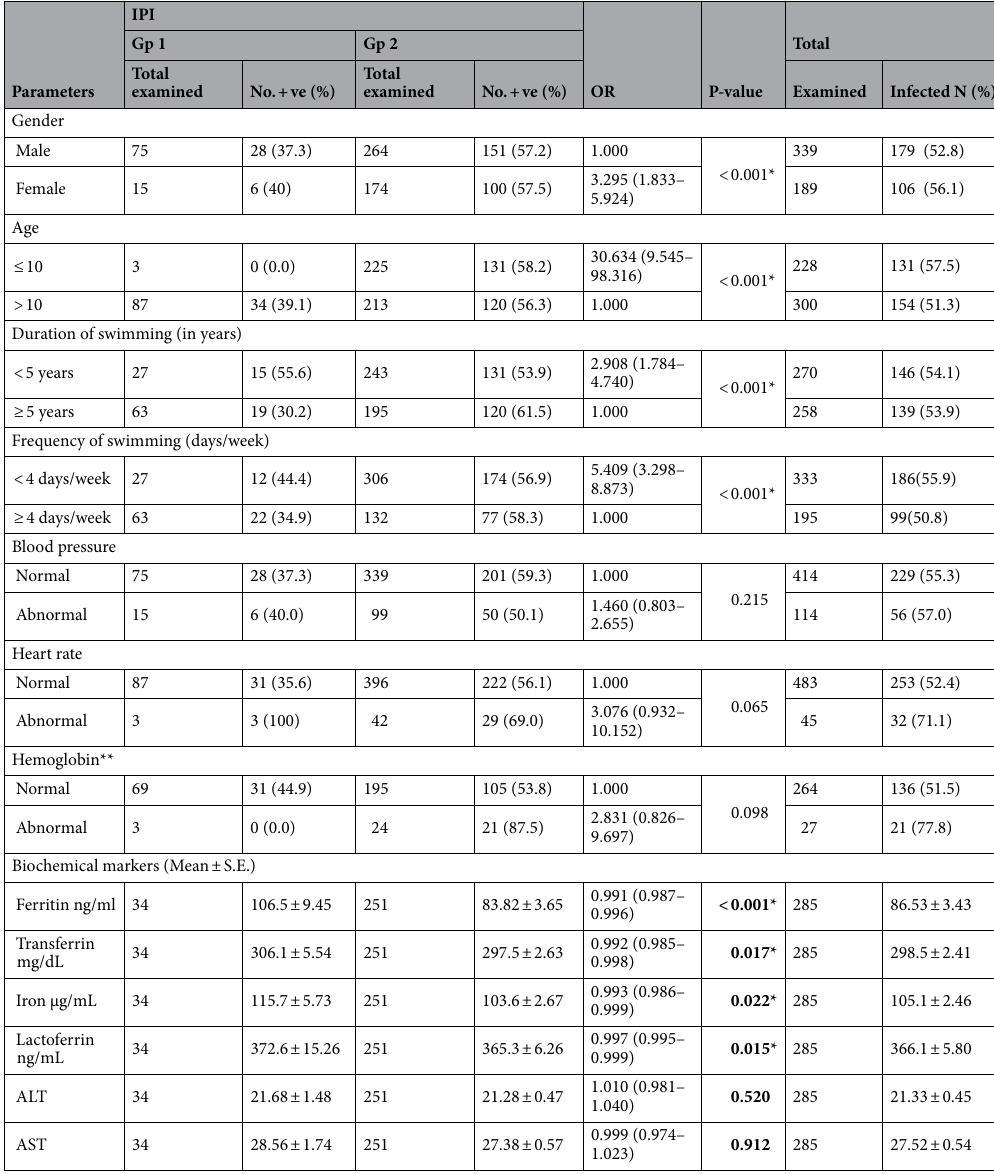
Table 5. Intestinal parasitic infections in relation to some demographic and swimming data, physiological, hematological parameters, and biomarkers of young swimmers, and their effect on swimmers’ performance in the Winter Alexandria Championship 2020. Gp group, + ve positive, ALT alanine transaminase, AST aspartate transaminase, OR odds ratio, CI confidence interval, LL lower limit, UL upper limit. *Statistically significant at p ≤ 0.05, **sample size was 291. Gp1: Achieved the best record in the Championship. Gp2: The swimmers who have a long time and low scores in the Championship or who are under training. N.V. of Hb: 11.5 g/dl